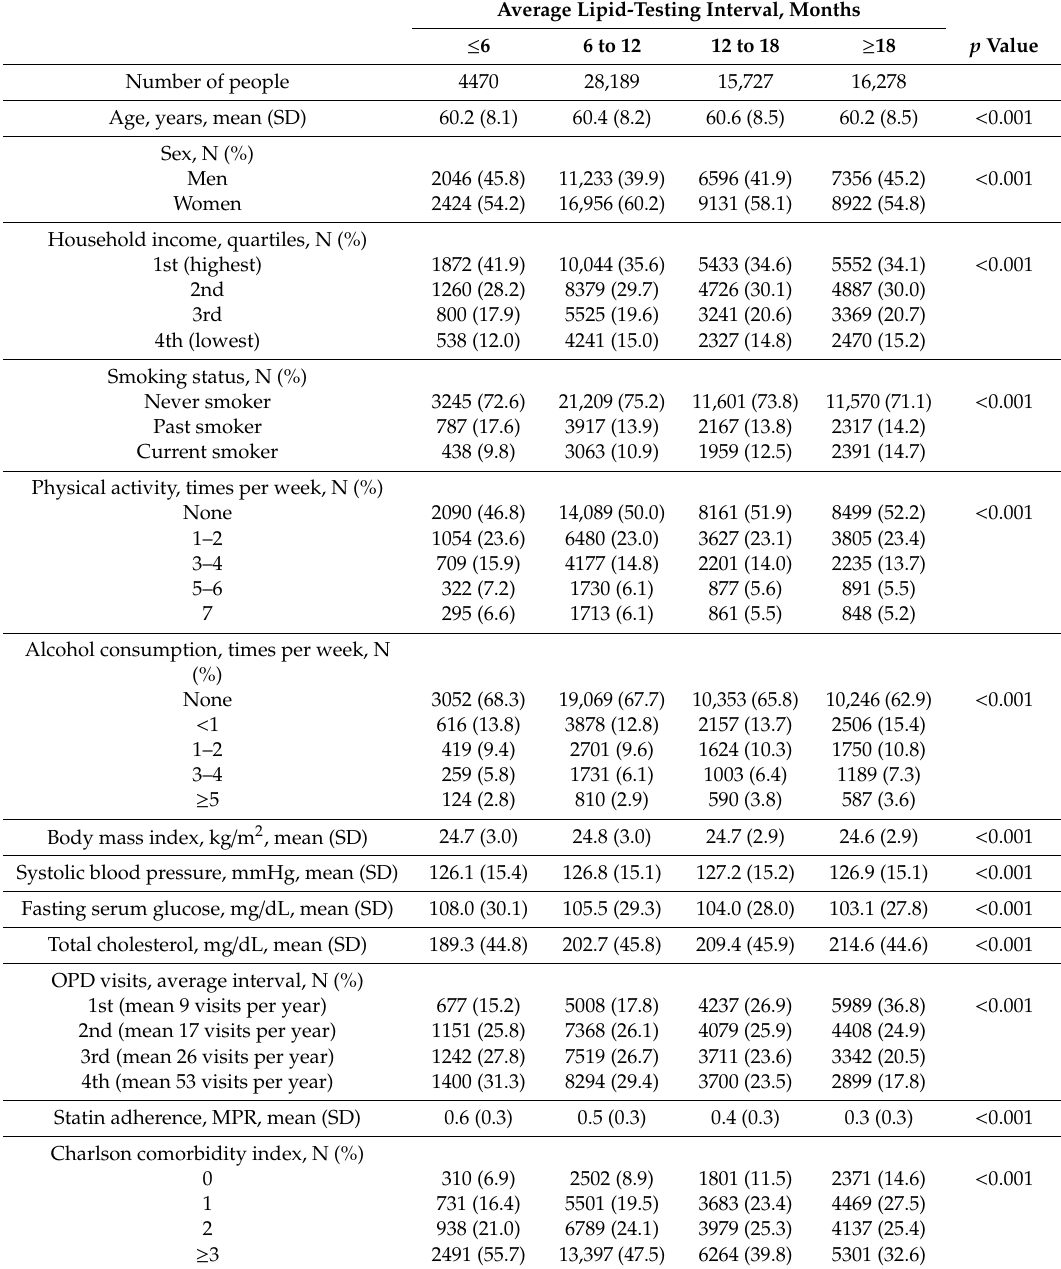
Table 1. Descriptive characteristics of the study